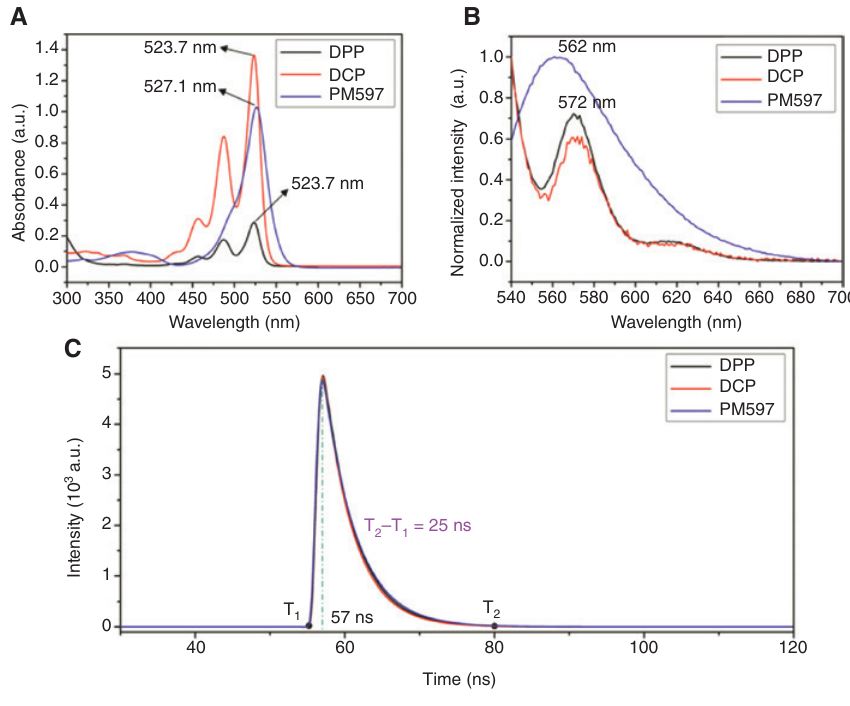
Figure 3: The optical properties of three laser dyes. Absorption spectrum (A), emission spectrum (B) and fluorescence lifetime (C) of the DPP, DCP or PM597 in the CH